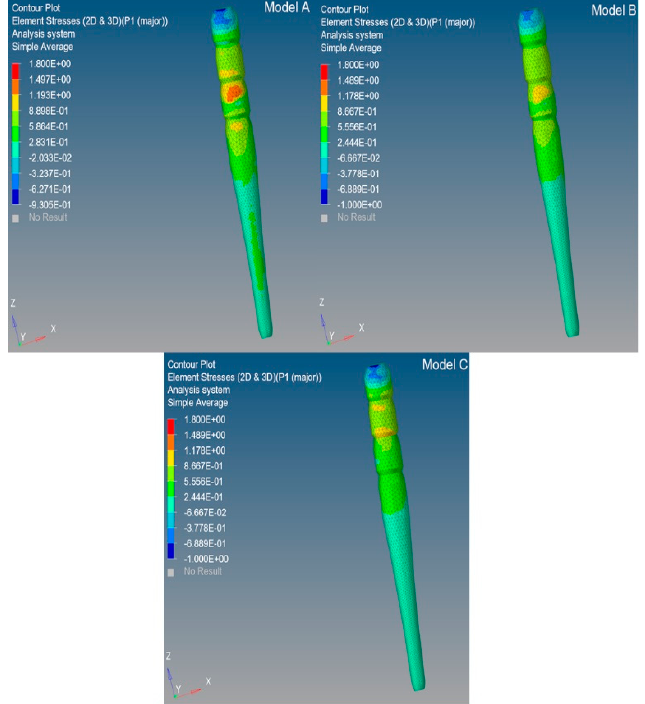
Figure 5. Models A, B, and C : maximum principal stress distribution at the interface between the post and surrounding structures from the coronal to the apical part.